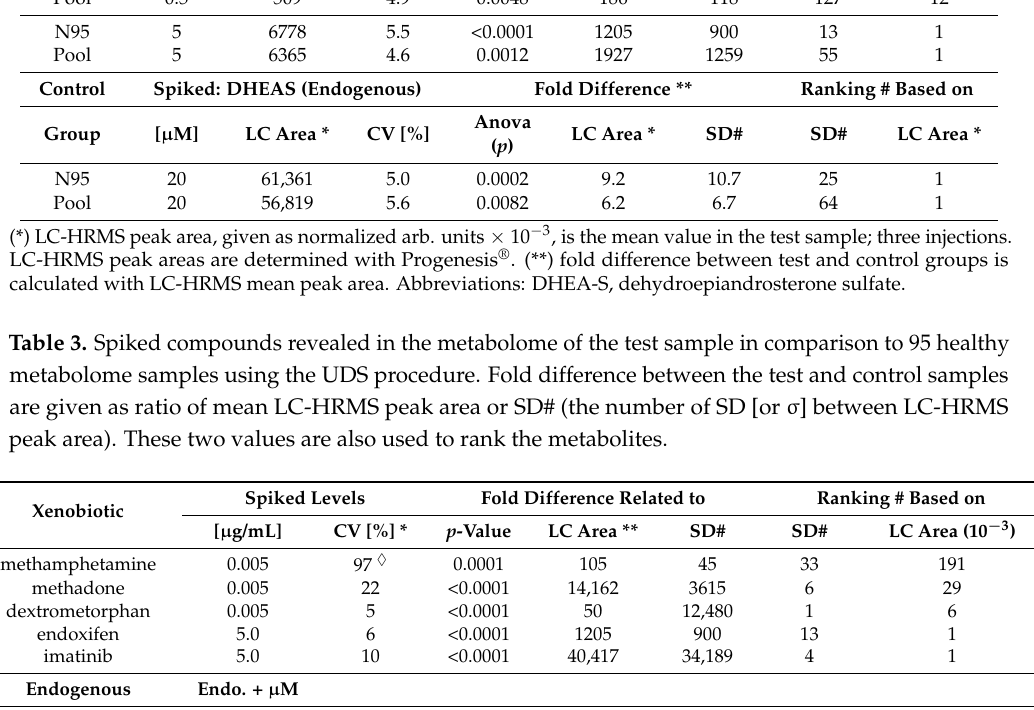
(*) CV is calculated with LC-HRMS peak area in the test sample (triplicate injections). (**) fold difference between the test sample and control samples (N95) is calculated with LC-HRMS mean peak area. ( ♦ ) with a CV > 25% (Filter #2), methamphetamine would be the only discarded spiked